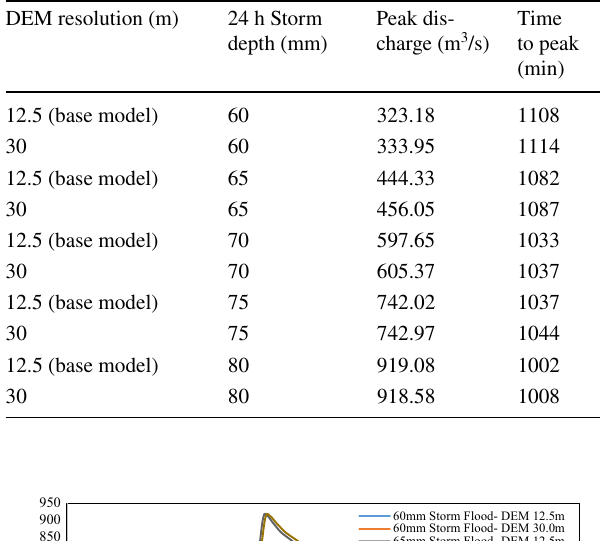
Table 4 Flood hydrograph of calibrated GSSHA Base model for five 24-h floods of 60–80 mm cumulative storm depths compared to hydrographs corresponding to GSSHA model based on 30 m resolu- tion DEM